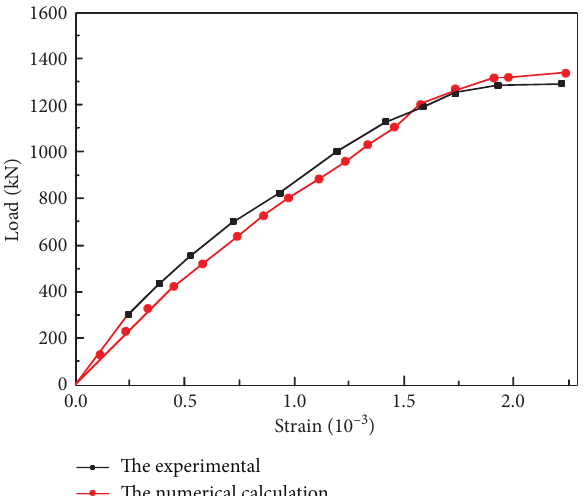
Figure 9: Comparison of the load-strain curve between numerical calculation and experimental of the reinforced concrete short column simplified model under axial compression.